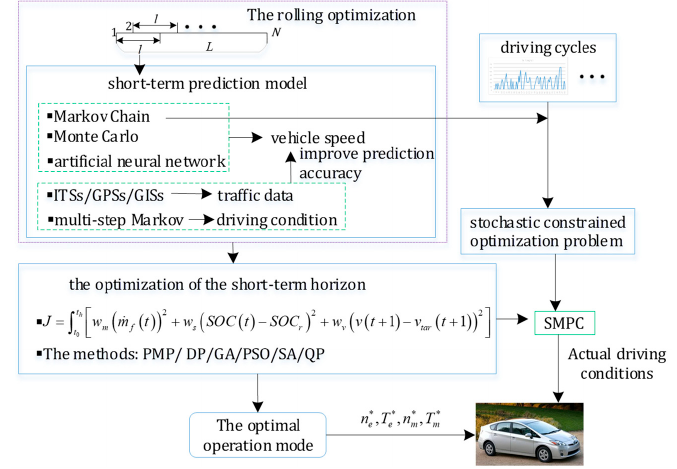
Figure 5. Depiction of the main research areas of the MPC-based strategy